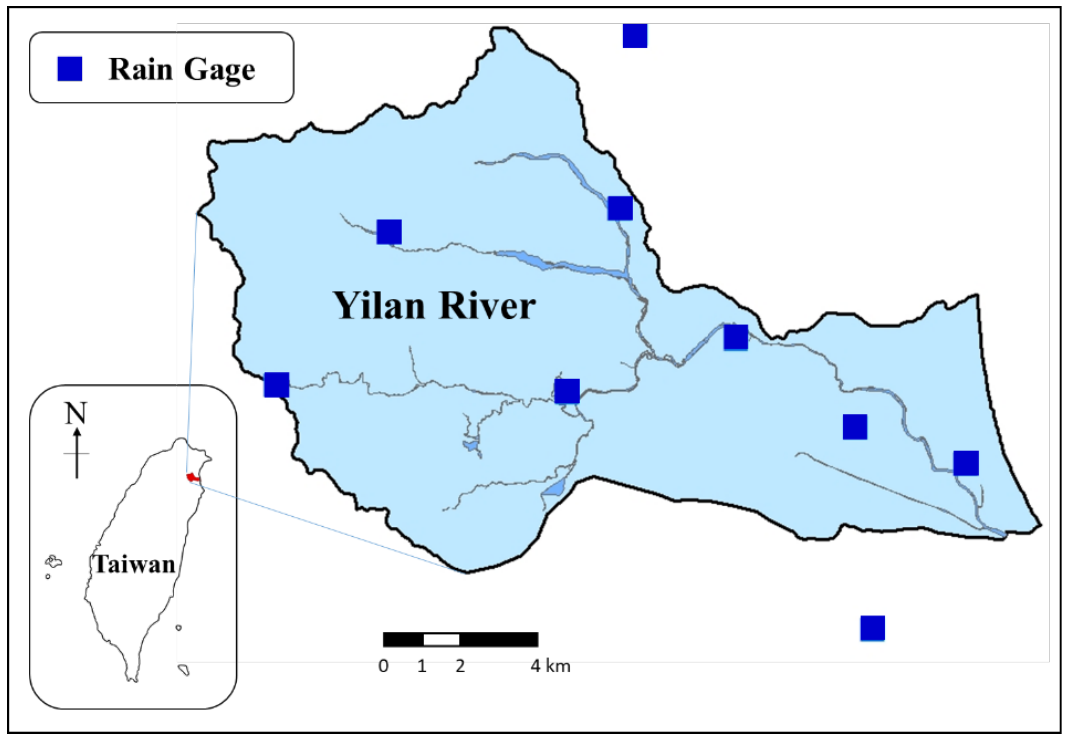
Figure 6. Locations of the study area and rain gauges.